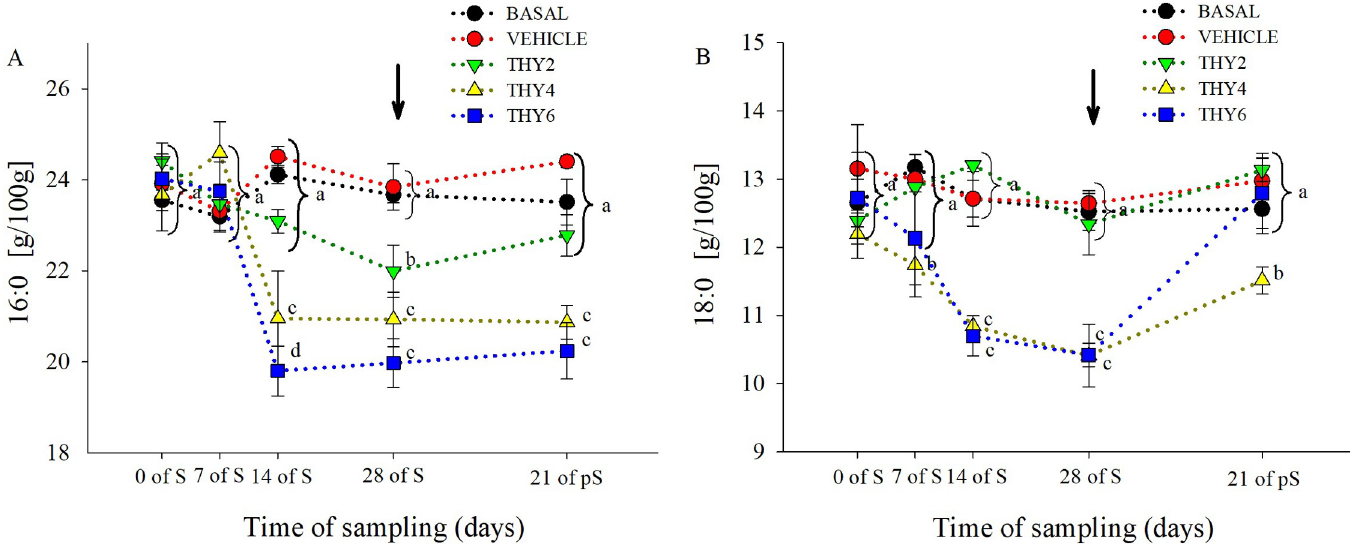
Fig 4. Concentration of saturated fatty acids of quail egg yolk. Mean ± SEM of content (g/100 g FAME) of (A) palmitic (16:0) and (B) stearic acids (18:0) of quail egg yolk laid by females fed on the control diets (BASAL and VEHICLE) or supplemented with 2, 4, and 6.25 g of thymol/kg of feed (THY2, THY4 and THY6, respectively) at 0, 7, 14, and 28 days of the supplementation period (S) and after 21 days of supplement withdrawal (pS). Arrow pointing down indicates the end of the S period. Different letters (a, b, c) indicate statistical differences. Brackets refer to measurements within a time of sampling. The same 25 females (5 per diet supplied) were analyzed on each of the five sample points (125 eggs total).